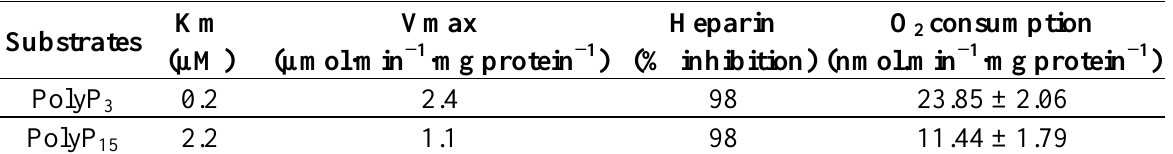
Table 2. Characterization of PPX activity in membrane preparation of mitochondria of R. microplus embryos on the 9th day of